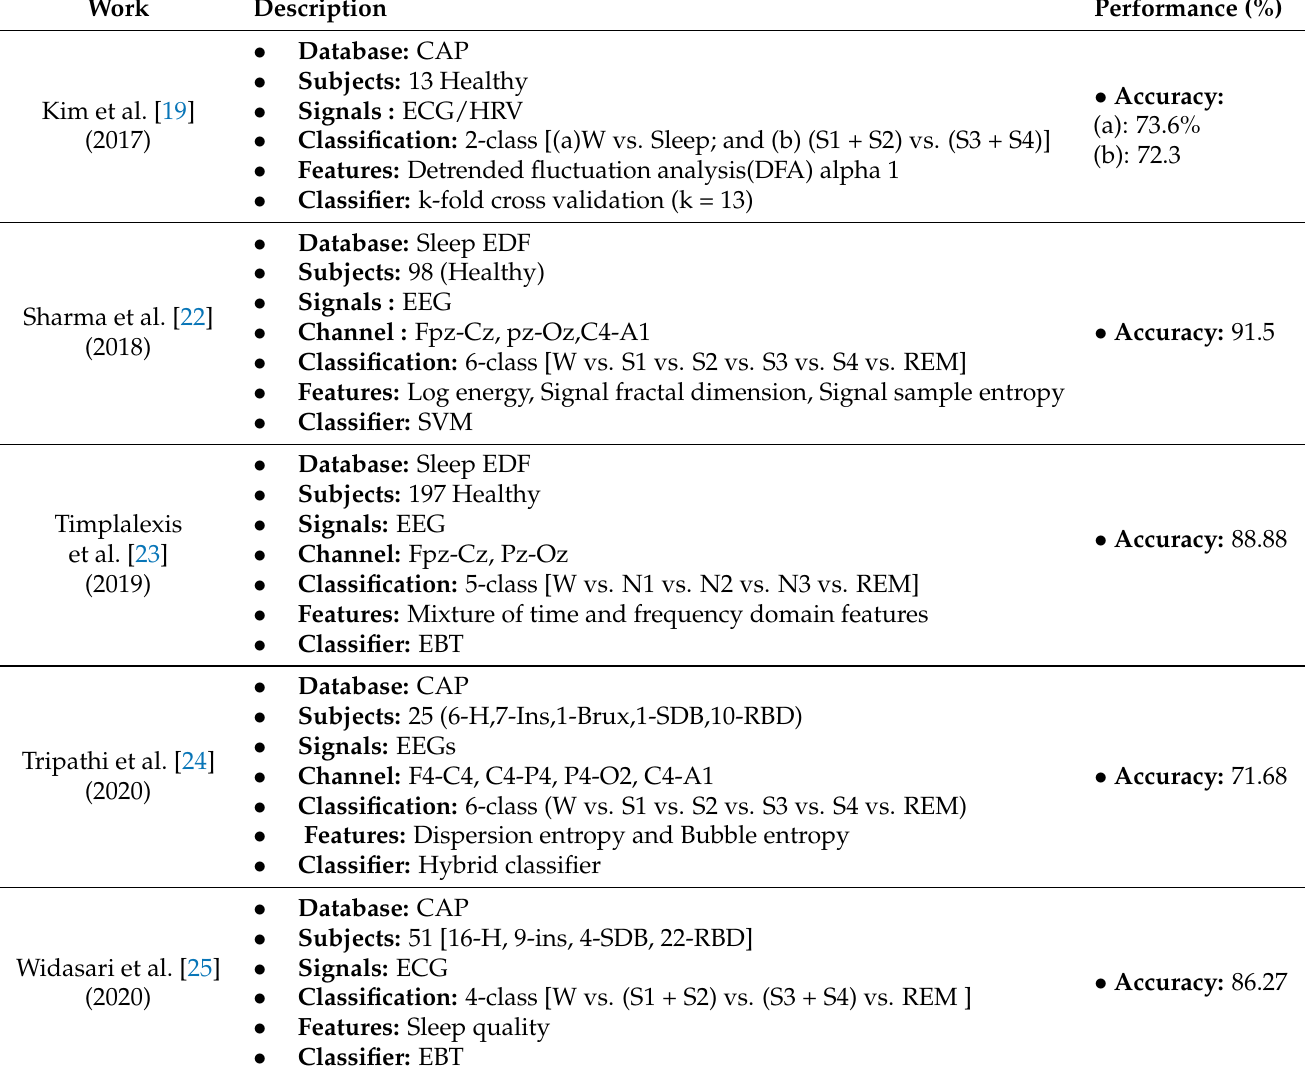
Table 1. Summary of the state-of-the-art automated sleep stage classification studies conducted.